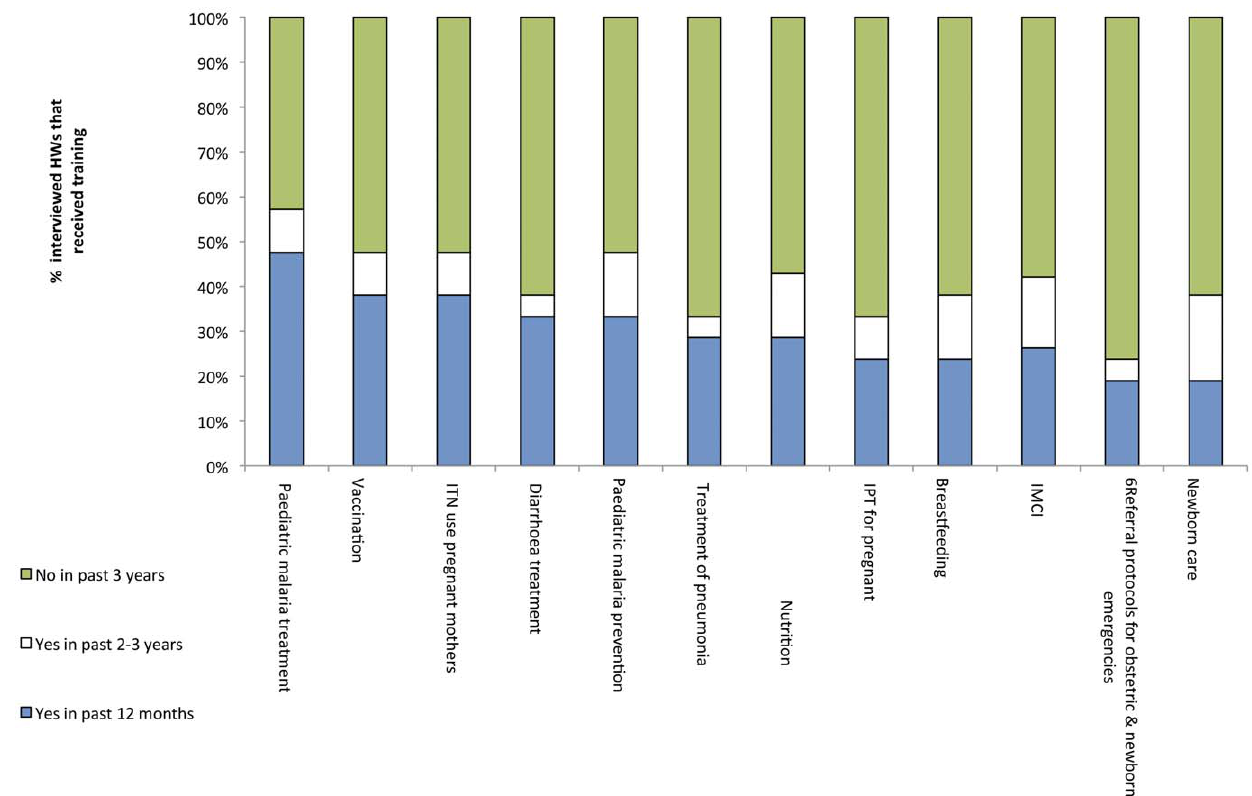
Figure 2. Training received by health workers in Jigawa State, Nigeria.